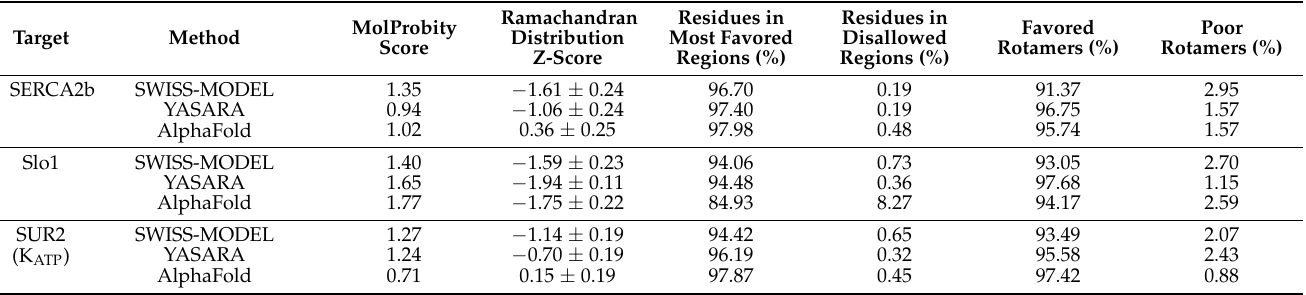
Table 1. Quality parameters of predicted full-length structures of target